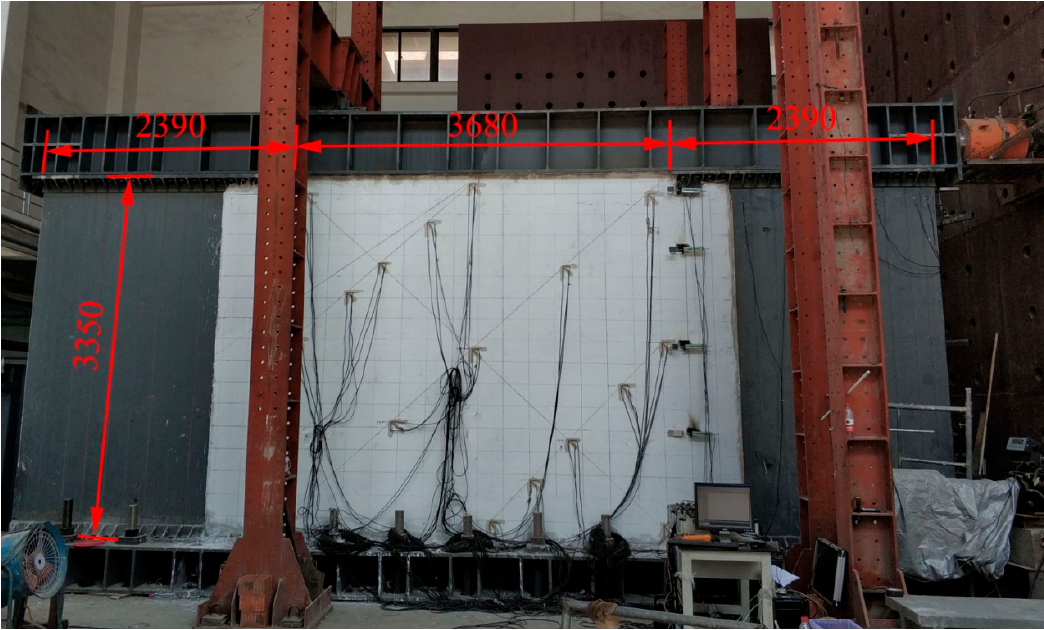
Figure 4. Field test diagram of specimen W2 (units in mm).